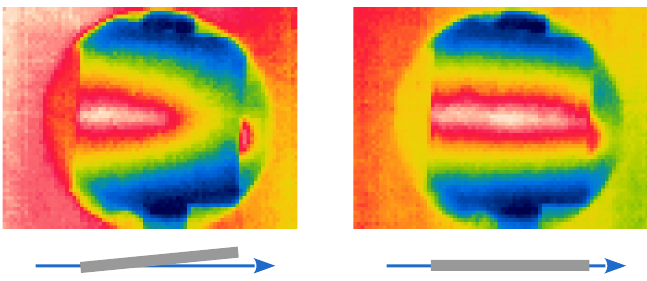
Figure 4. Thermal images of the lithium target during recent tests with a 1.5GeV electron beam at MAMI. The orientation of the target with respect to the beam is schematically depicted at the bottom. Left: Target and beam misaligned, the lithium was only partially heated. Right: Correct alignment, the heat is equally distributed. In both cases a beam intensity of 2 µ A was used and the maximum temperature of 28 ◦ C hardly exceeded room temperature. The red spot on the right side of the target results from a flange of the vacuum system in the background.